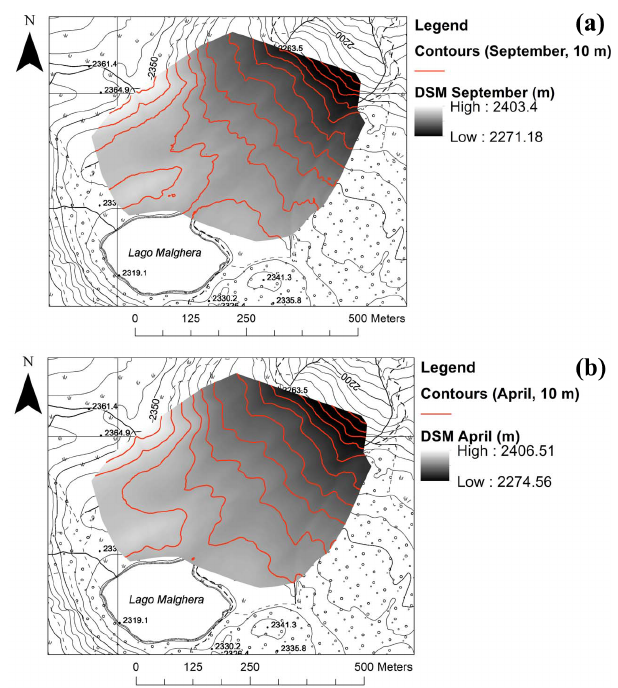
Figure 5. Digital surface model (DSM) of the two surveys. (a) DSM of the survey performed during September 2013. (b) DSM of the survey performed during April 2014. For both DSMs, a 5 × 5cm 2 cell size has been used.